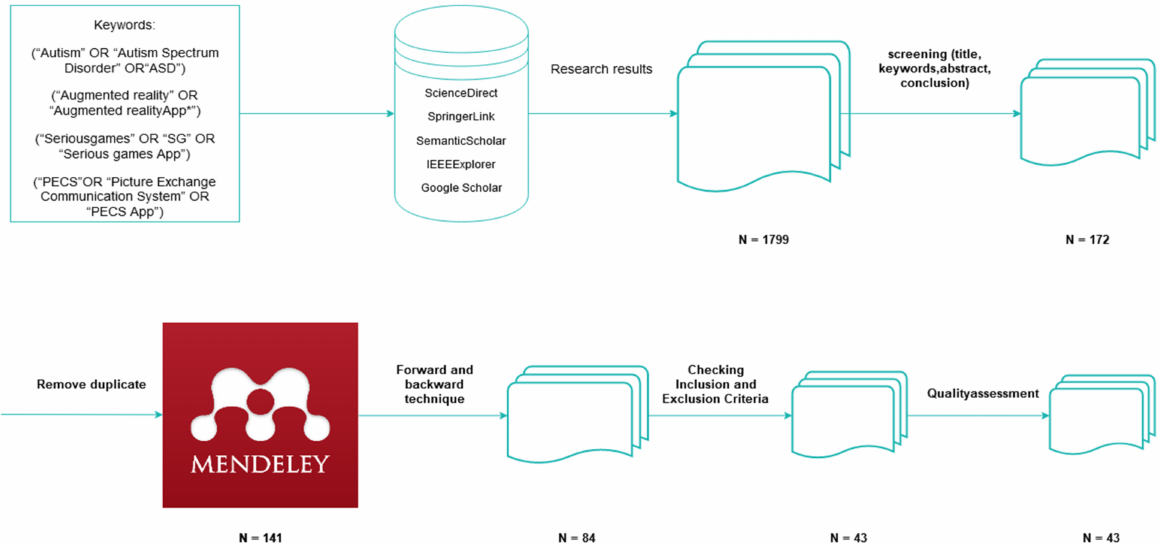
Figure 9. Search